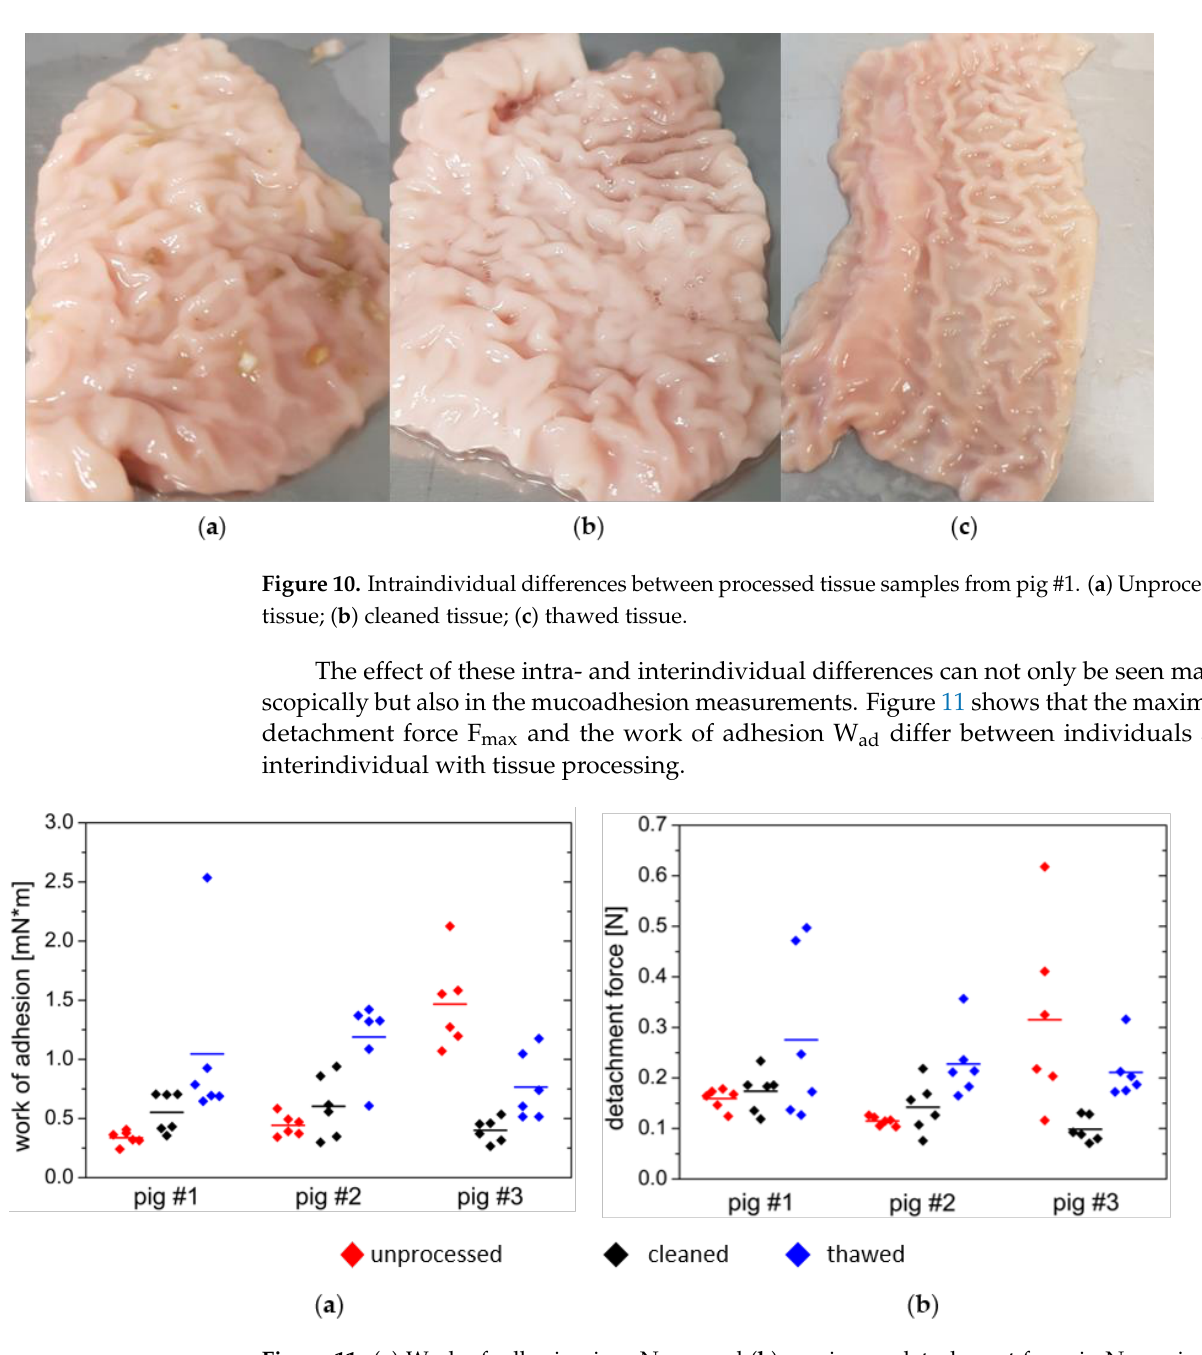
Figure 10. Intraindividual differences between processed tissue samples from pig #1. ( a ) Unpro- cessed tissue; ( b ) cleaned tissue; ( c ) thawed tissue.